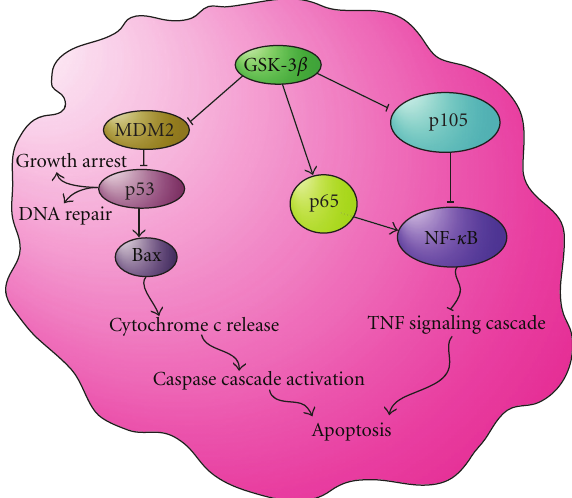
Figure 3: GSK-3 β ’s role in apoptosis signaling. The above schematic shows the role of activated GSK-3 β and its role in regulating apoptosis. Active GSK-3 β inhibits MDM2 regulation of p53, leading to DNA repair and growth arrest, and in some cases the activation of the caspase cascade through Bax to promote apoptosis. Active GSK-3 β also positively regulates NF κ B by activating IKK, I κ B, and p65, leading to the inhibition of TNF-mediated apoptosis. These actions inhibit the initiation of apoptosis through the TNF signaling